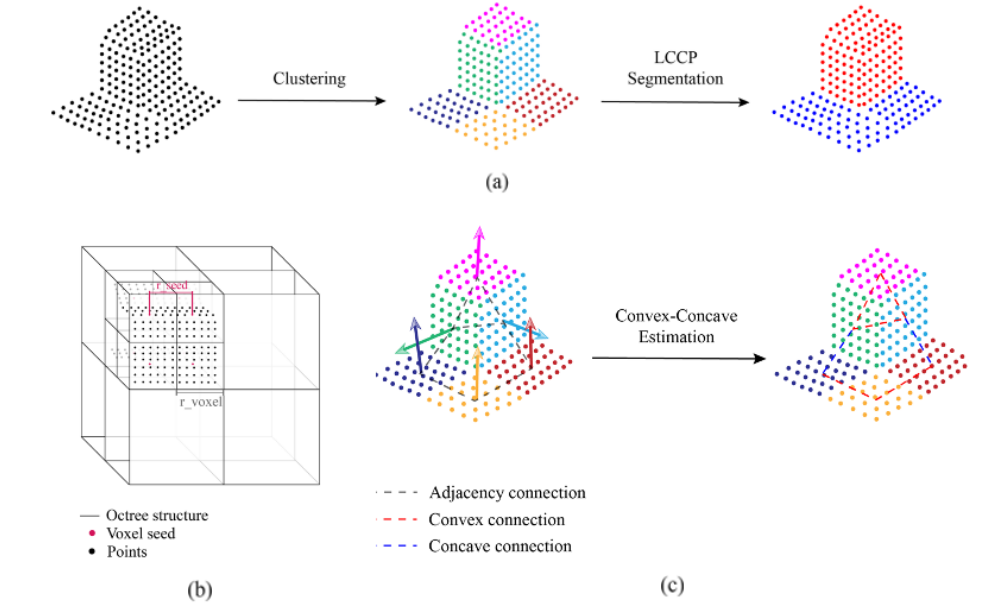
Figure 2. Illustration of two-level graphical model generation. ( a ) The fundamental process of supervoxel-based object segmentation. ( b ) The octree structure used for supervoxel clustering. ( c ) The locally convex connected patches (LCCP) segmentation scheme. Colored arrows show the corresponding normal vectors of